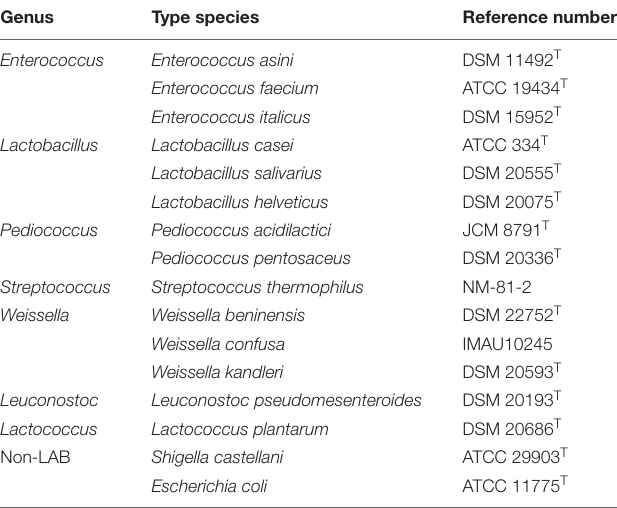
TABLE 1 | Strains used in this study.